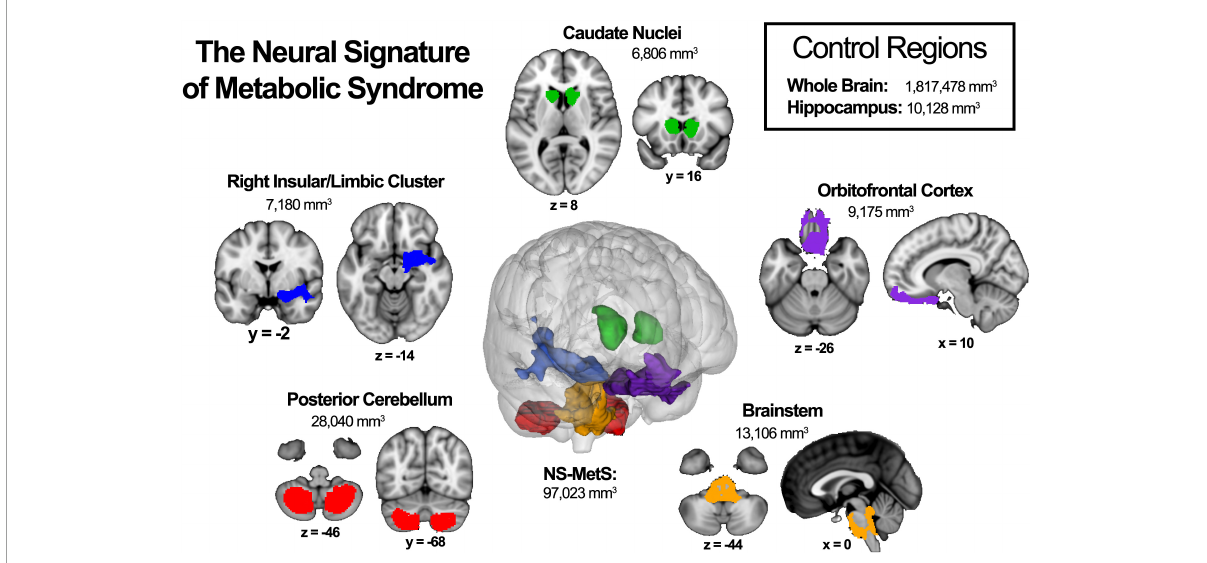
FIGURE1 The neural signature of metabolic syndrome (NS-MetS) as defined by Kotkowski et al. (2019). Each indicated region represents one of the five main clusters that comprise the NS-MetS. Control regions include gray matter densities from the whole brain and hippocampal, neither of which are part of the